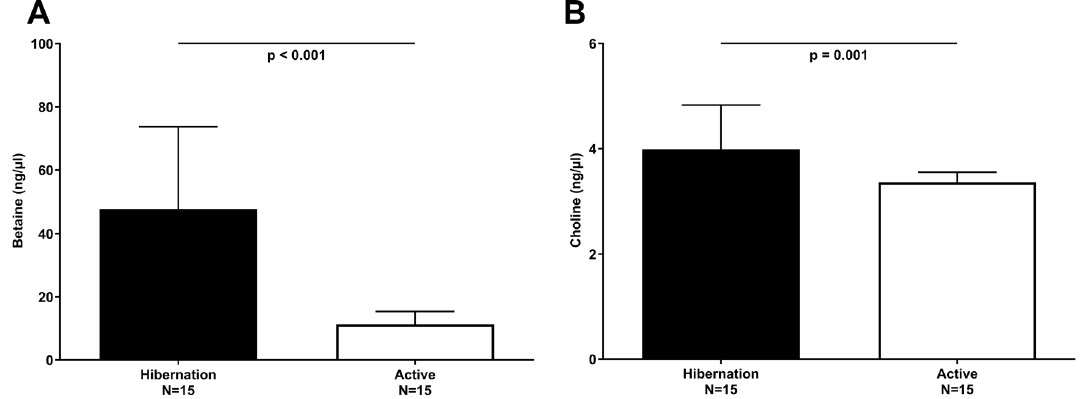
Figure 3. Circulating levels of ( A ) betaine and ( B ) choline in free-ranging brown bears from the longitudinal Scandinavian Brown Bear Research Project during hibernation, i.e. at hibernation (black bars, during winter) and non-hibernation (white bars, during summer). Results are shown as median (interquartile range). p values as assessed by non-parametric Wilcoxon signed-rank test. Number of brown bears included in each group is depicted. Aiming to investigate differences between hibernating and active time points, four bears were investigated twice in two consecutive years and treated as independent samples for this